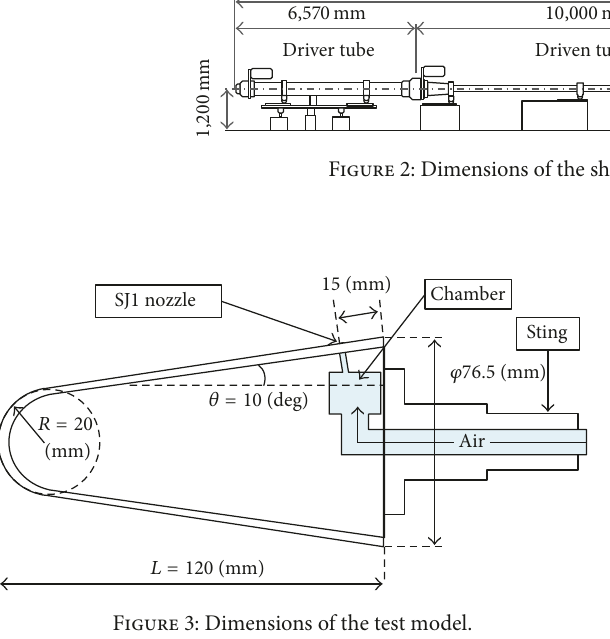
Figure 3: Dimensions of the test